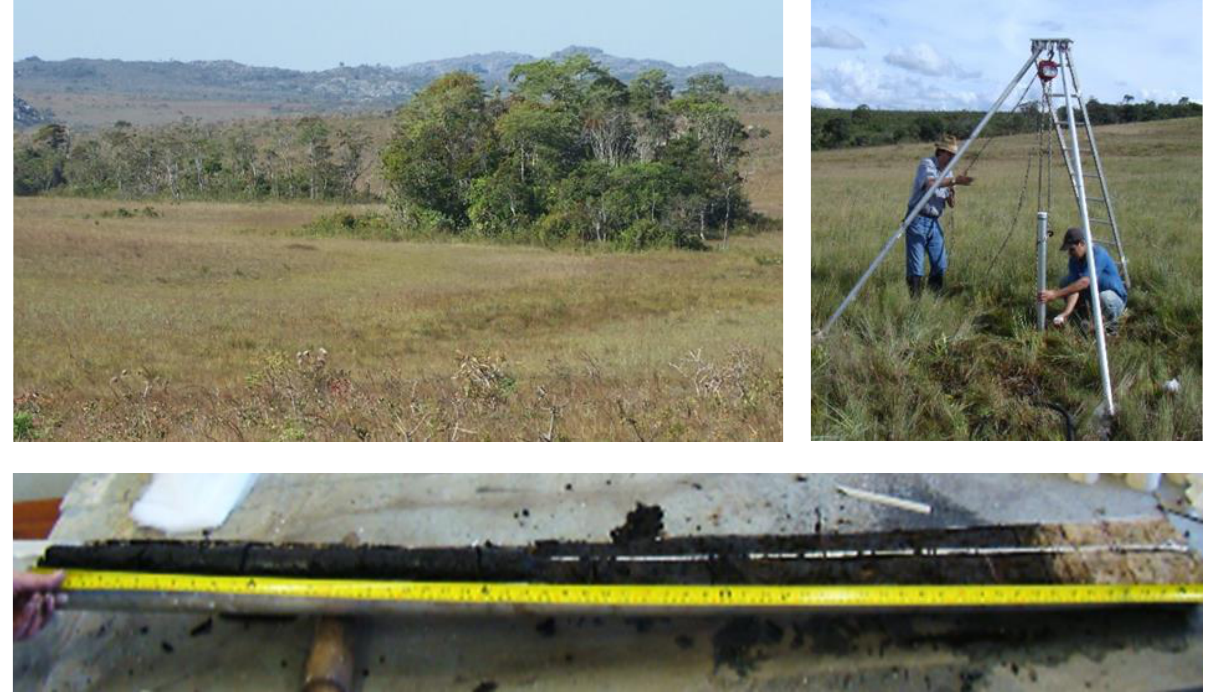
Figure 2. Top left: Peatland vegetation in the Serra do Espinhaço is dominated by grassland ( campo úmido ) with patches of forest vegetation ( capões ). Top right: Peat core being hoisted using a pulley mounted on a tripod. Bottom: Peat core exposed after cutting the aluminium tube open (notice the yellowish mineral basal layer at the